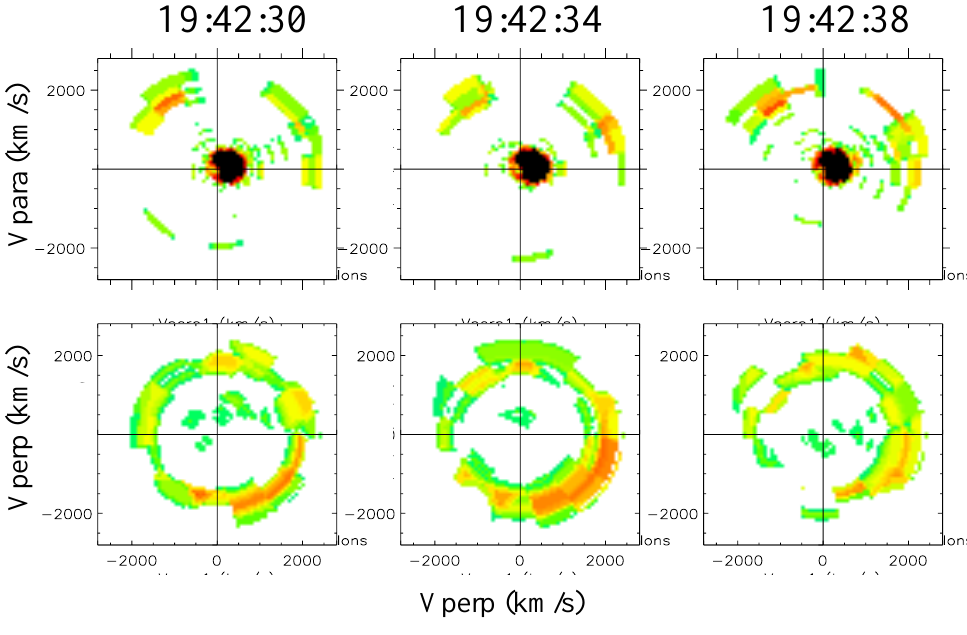
Fig. 5. Two-dimensinal cuts of the distribution function of the dispersed structure observed on 28 January 2001. The upper plots correspond to pitch-angle distributions. The lower plots are cuts in a plane perpendicular to the magnetic field shifted by 1000km/s along the parallel